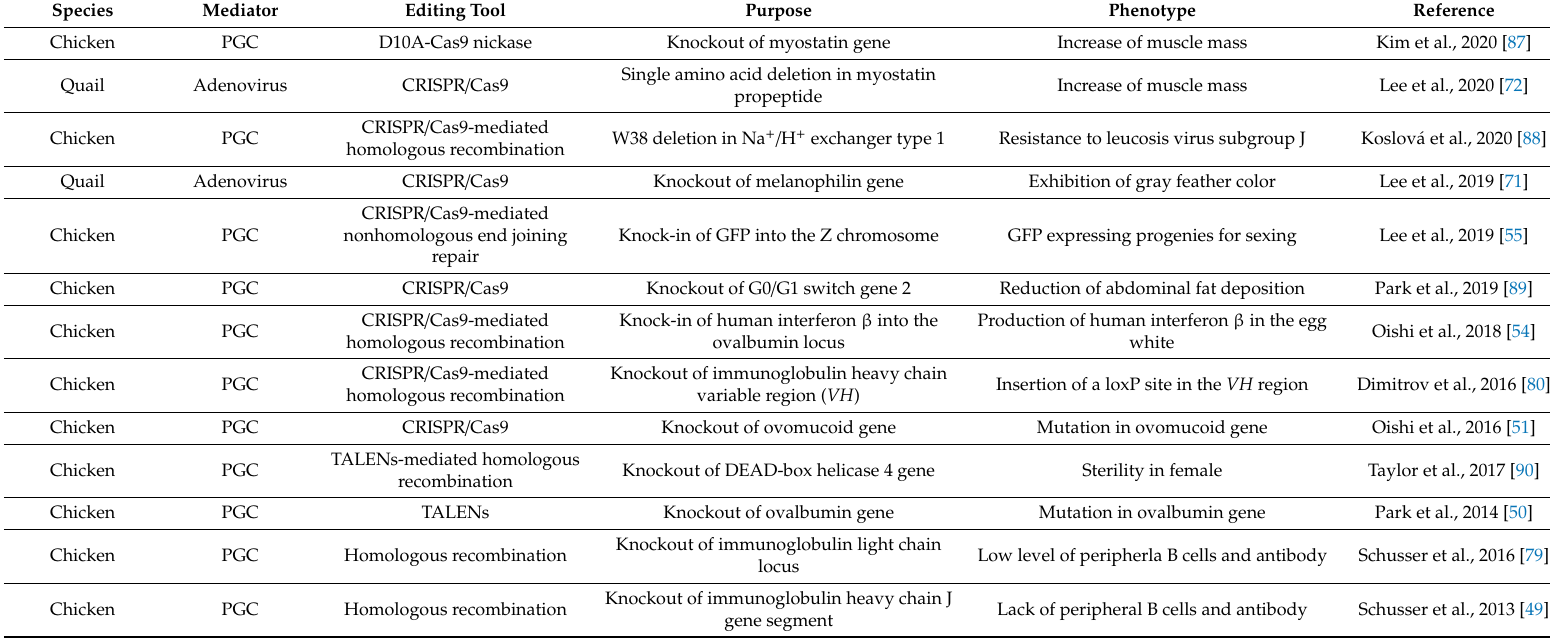
Table 1. Published studies of PGC- and adenovirus-mediated genome editing in avian